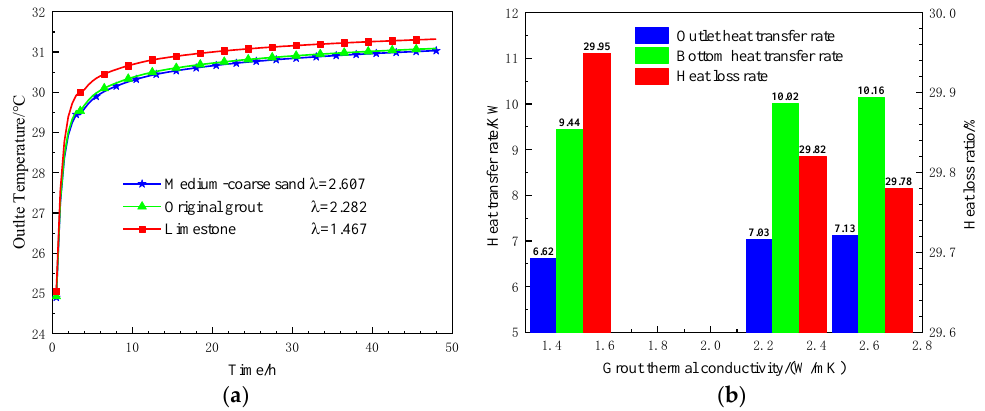
Figure 13. Sensitivity of outlet temperature and heat transfer rate to backfill grout materials. ( a ) Sensitivity of outlet temperature to backfill grout materials. ( b ) Sensitivity of heat transfer rate and heat loss ratio to backfill grout materials.